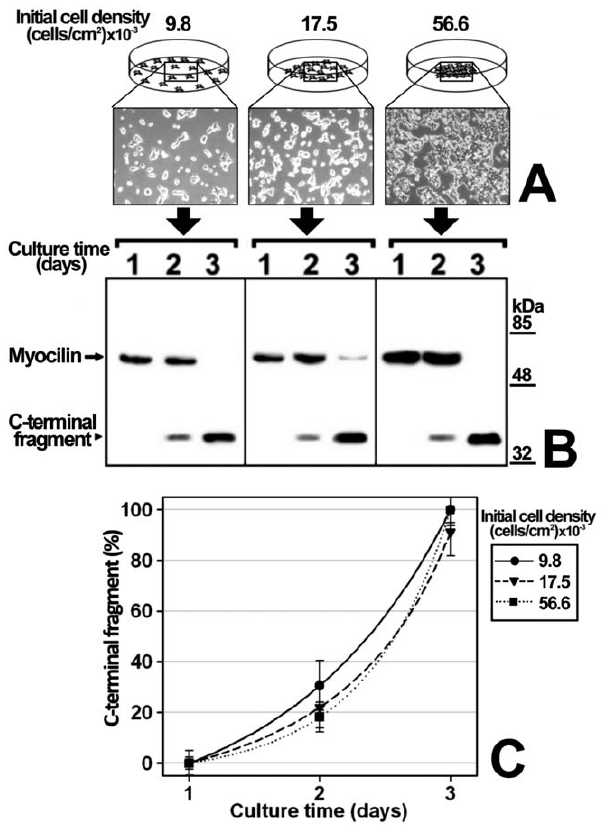
Figure 2. Influence of initial cell density in myocilin proteolytic processing. (A) HEK-293T cells (400000 cells/plate) were seeded in different areas of cell plates using circular frames to obtain the indicated cell densities. Magnification of phase contrast micrographs: 40X. Cells were transfected with a cDNA construct encoding myocilin- myc as described in Materials and Methods. After transfection, culture medium aliquots were collected every day. (B) Extracellular recombi- nant myocilin was analyzed by 10% polyacrylamide SDS-PAGE and Western blot using an anti-myc monoclonal antibody. Equal amount of total protein was loaded into each well. The horizontal arrow and arrowhead indicate the position of full-length myocilin (55-kDa), and the 35-kDa C-terminal fragment, respectively. (C) Quantitation by densitometry of the C-terminal fragment detected in B. Values represent the proportion of this myocilin fragment, expressed as indicated in Fig. 1B. Error bars correspond to the SD of three independent experiments carried out in triplicate. Two-ways ANOVA showed an effect of culture time ( p , 0.001) but not of cell density ( p . 0.1). No significant interaction between culture time and cell density was observed (p . 0.1).